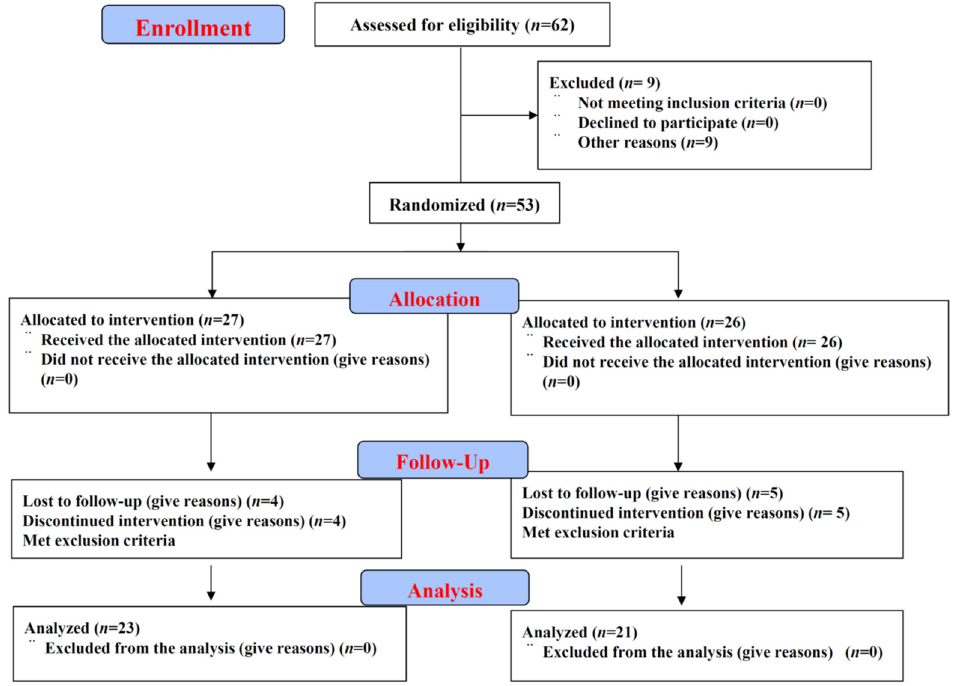
Figure 1. Flow diagram of the progress through the phases of a randomized trial of two groups (enrolment, intervention allocation, follow-up and data